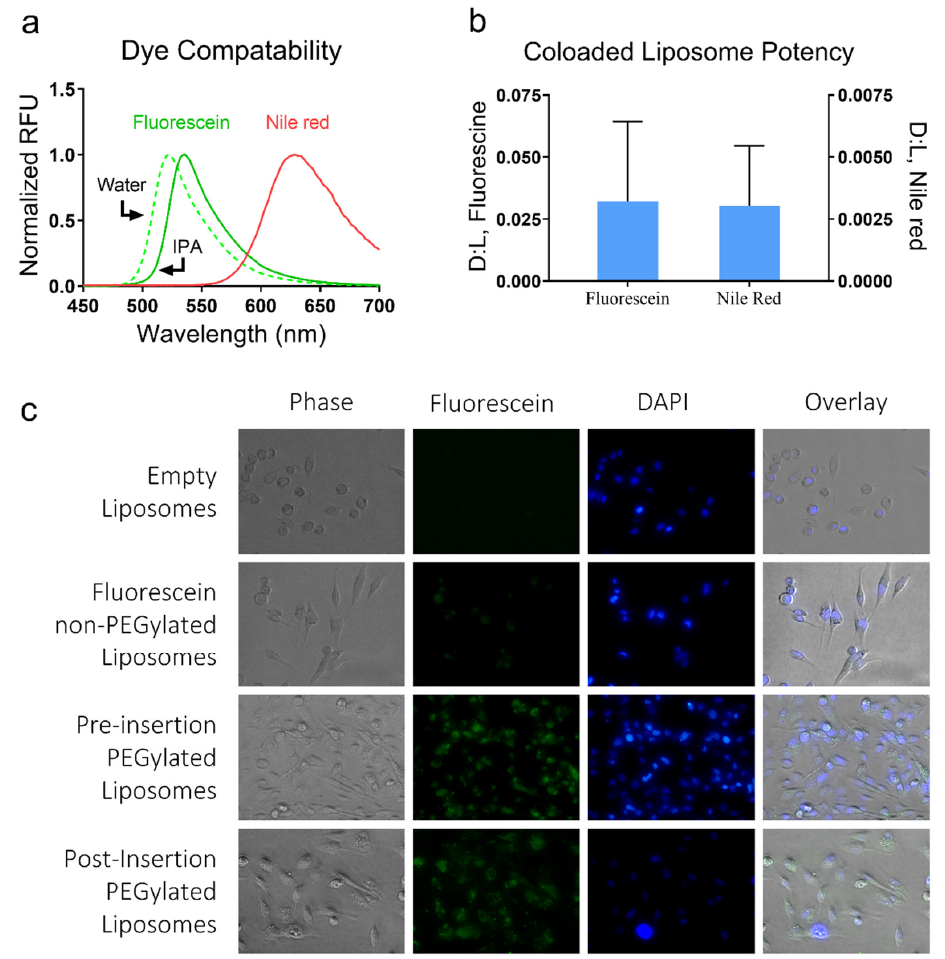
Figure 5. The use of thermal equilibration as a universal encapsulation method. Liposomes are uniquely capable of sequestering both lipophilic and hydrophilic molecules. ( a ) Using the equilibration approach, liposomes were loaded with the hydrophilic and lipophilic dyes Fluorescein and Nile Red, respectively. These dyes differ greatly in fluorescence emission and can be easily distinguished. ( b ) The liposomes were then co-loaded by incubating with a mix of fluorescein and Nile Red. Analysis of liposome emission spectra revealed two peaks indicative of both dyes being sequestered. ( c ) Liposomes loaded with fluorescein (green) were targeted to MDA-MB-231 breast cancer cells in vitro using PEG-DSPE-Mal covalently bonded to CD44 as a targeting molecule. The PEGylated lipid was introduced either during vesiculation or during thermal equilibration.